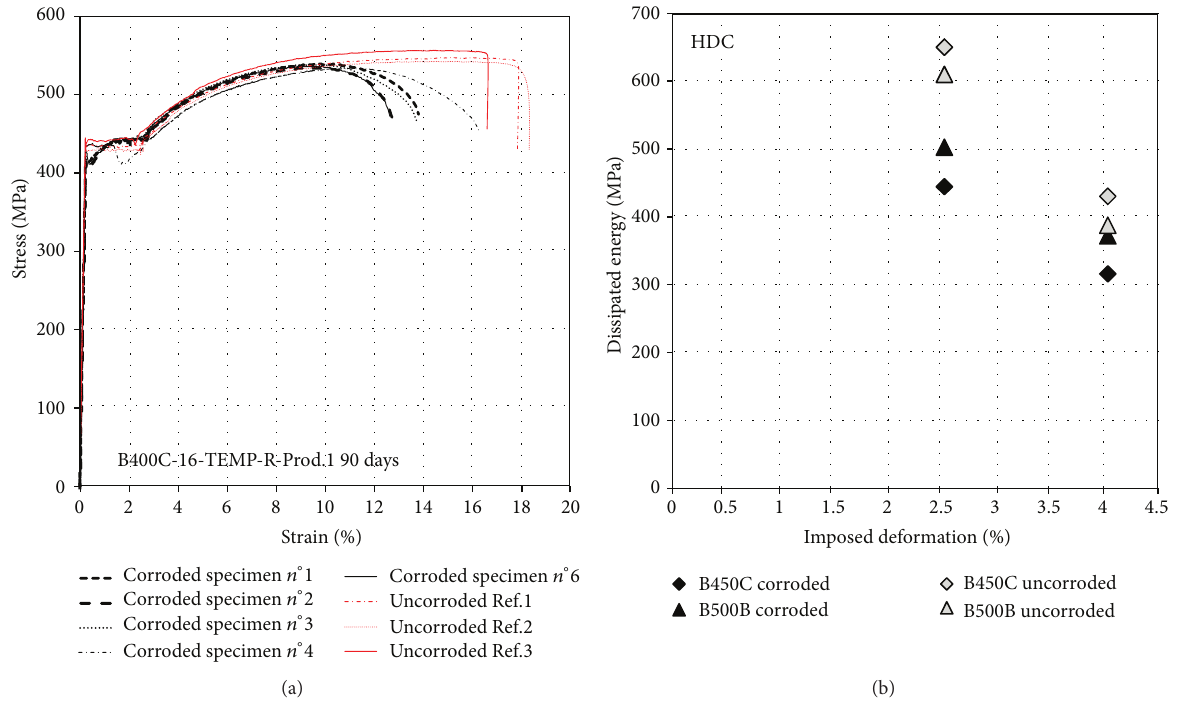
Figure 5: (a) Comparison of stress-strain curves obtained from uncorroded ( curves Uncorroded Ref.1, Ref.2, and Ref.3 ) and corroded ( curves of specimens n ∘ 1, 2, 3, 4, and 6 ) specimens (B400C-16-TEMP, 90 days of corrosion, Lab. B), (b) comparison of the mean dissipated energy obtained from corroded and uncorroded specimens (B450C and B500B) for two different levels of imposed deformation and 𝐿 0 = 6𝜙